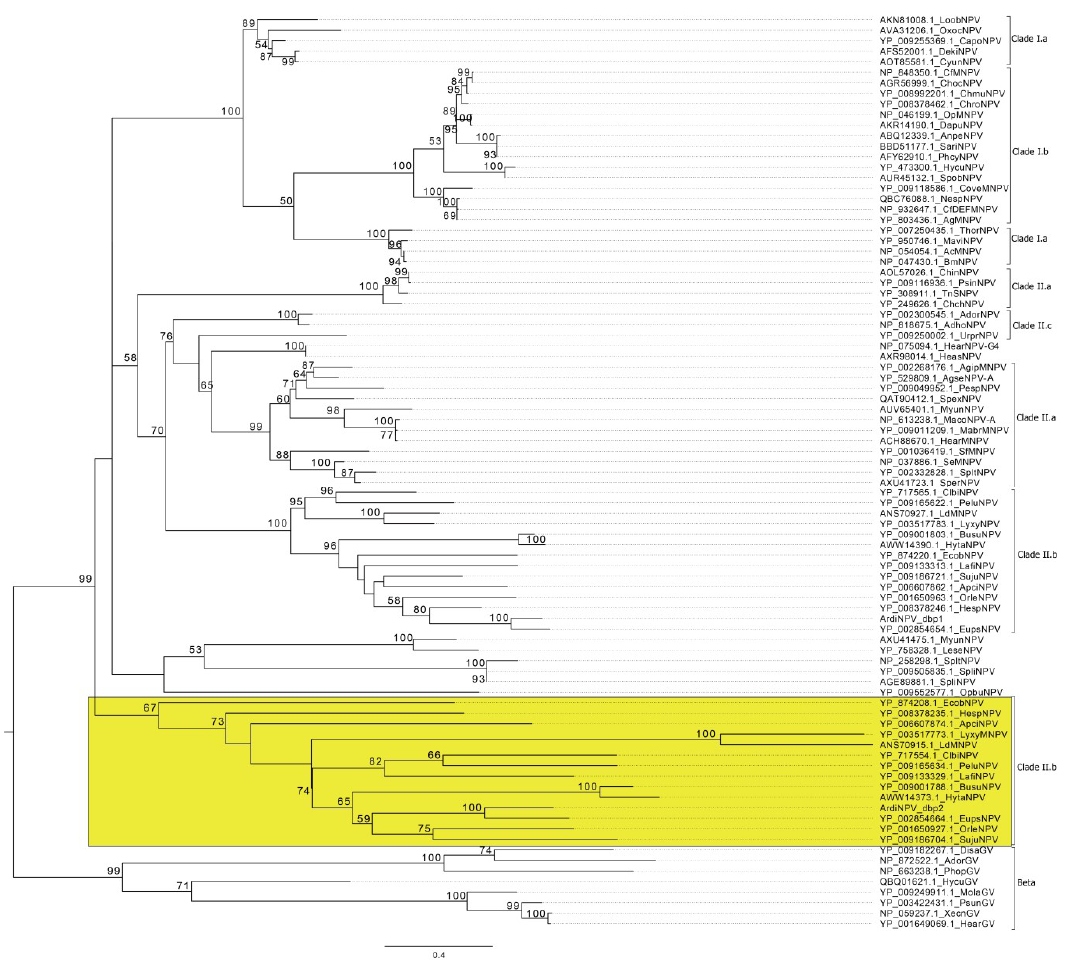
Figure 5. Analysis of the dbp duplicated gene. The phylogenetic tree was constructed using the baculovirus DBP protein by the Maximum Likelihood method with 1000 bootstrap values. Values of more than 50% are showed on the branch. The taxonomy lineages of the viruses are indicated on the right. The Clade II.b which has a second copy of dbp is markered with a yellow box.